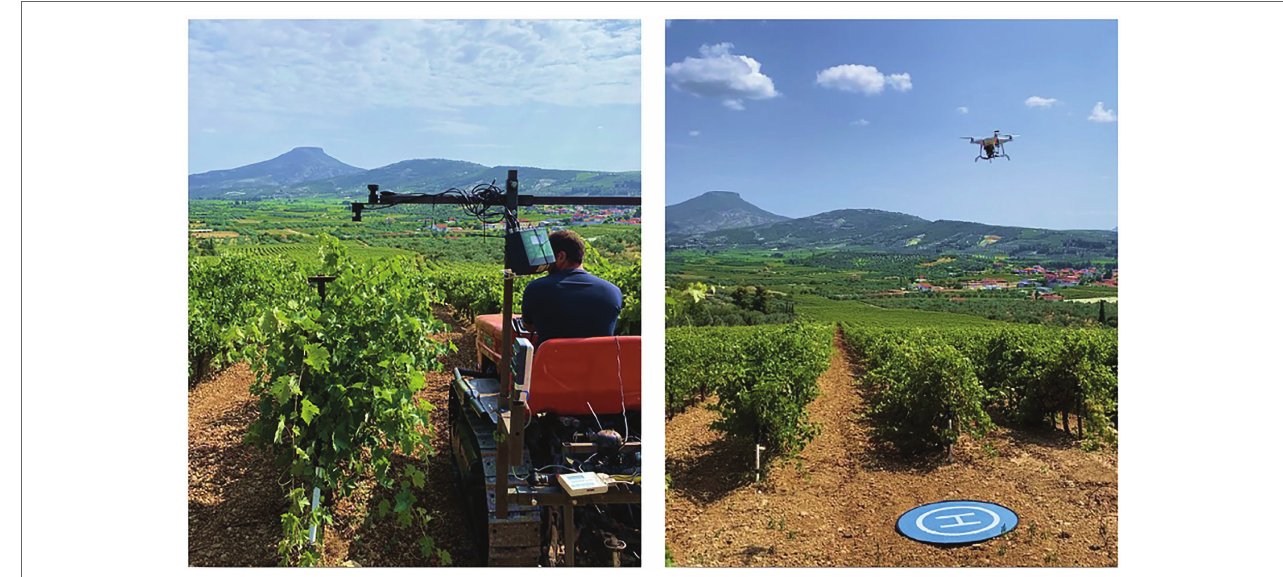
FIGURE 1 | Two vehicle-mounted crop reflectance sensors, UAV-acquired data, and Sentinel-2 archived imagery were used to estimate grapevine canopy properties. UAV, unmanned aerial vehicle.